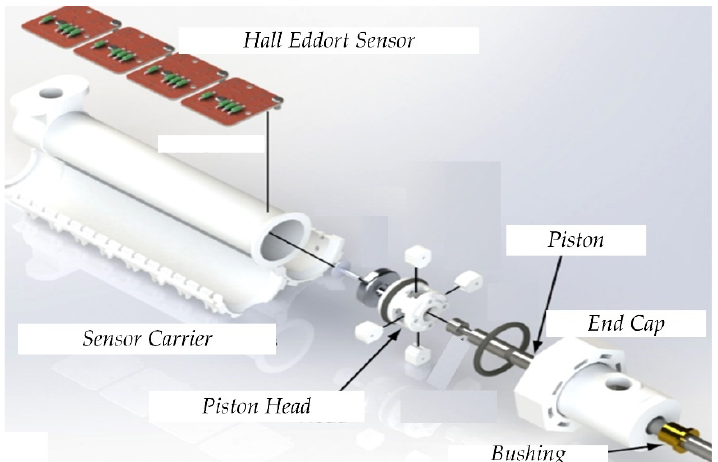
Figure 4. Pneumatic actuator structure diagram. Actuator test parameters: where, K p , K i are constants for proportional and integral control, V is the voltage, X is the quantity that needs to be regulated and X ref is the reference value.